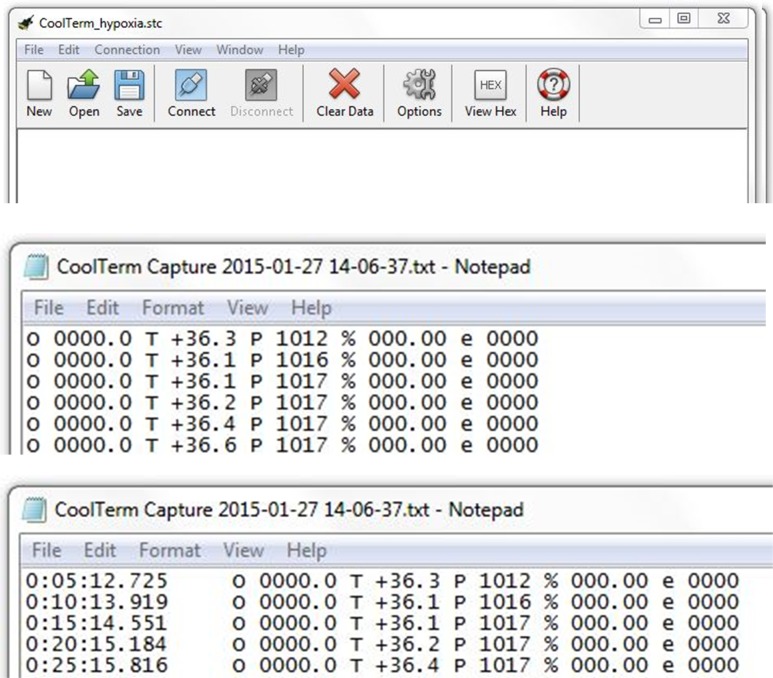
Screen-capture images of CoolTerm terminal window.Upper panel: CoolTerm quick access bar and ribbon; middle panel: format of the initial data output from CoolTerm; lower panel: format of the final data saved by CoolTerm with time-stamps (saved and opened as a Microsoft Notepad file).